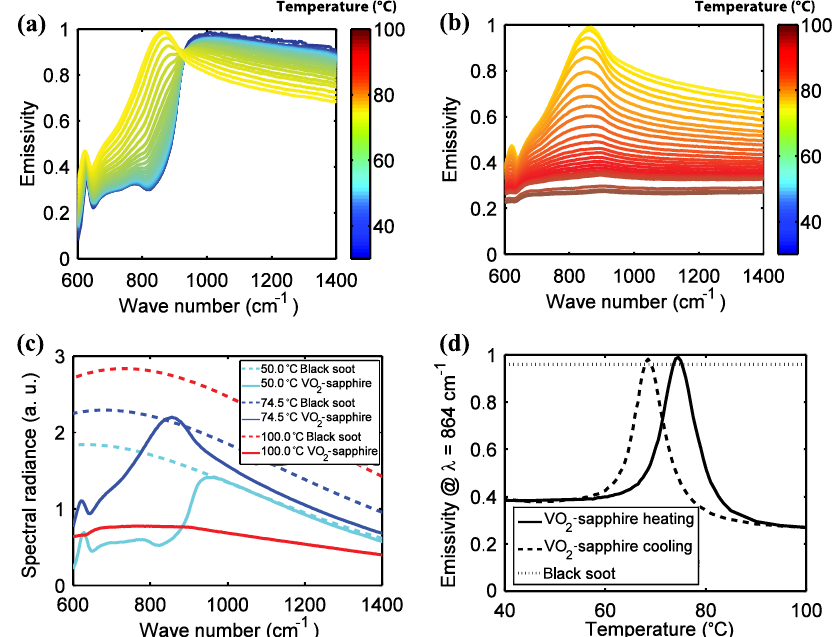
FIG. 2. (a),(b) Experimentally determined evolution of the VO 2 -sapphire emissivity for increasing temperature, separated into ranges of 35 (cid:2) C – 74 : 5 (cid:2) C and 74 : 5 (cid:2) C – 100 (cid:2) C for visual clarity. (c) Thermal emission density (spectral radiance) from black soot (dashed lines) and our VO 2 -sapphire sample (solid lines) for three different temperatures. The data were taken for increasing temperatures. (d) Thermal emissivity of the VO 2 -sapphire sample at a wave number of 864 cm (cid:1) 1 for heating (solid line) and cooling (dashed line), respectively. The dotted line denotes the assumed emissivity of the black-soot reference ( " ¼ 0 : 96